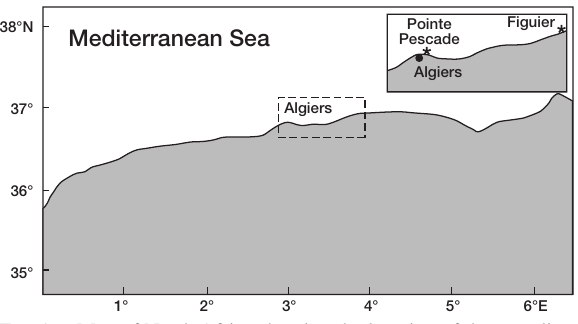
Fig . 1. – Map of North Africa showing the location of the sampling sites near Algiers in